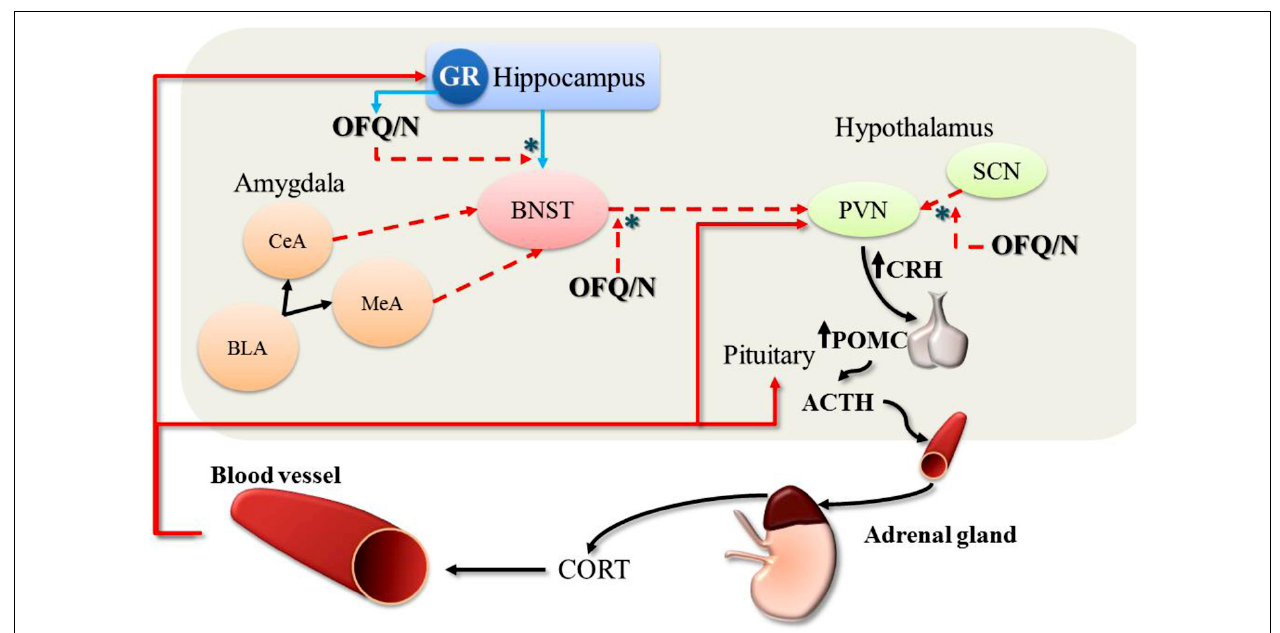
GABAergic outputs (red dashed arrows) from the BNST to the PVN, which attenuates the restraining influence of the BNST on PVN activity. Finally, nociceptin may also exert feed-forward effects on the HPA axis by suppressing inhibitory output from the SCN to the PVN. In this way, OFQ/N stimulates PVN neurons indirectly to produce CRH, which induces the expression of POMC and stimulates the release of ACTH. Collectively, these changes prolong or enhance the HPA axis response to stress. [Note: although depicted in this schematic for completeness, OFQ/N does not modulate amygdalar-outputs (CeA, central amygdala; MeA, medial amygdala; BLA, basolateral amygdala) to the